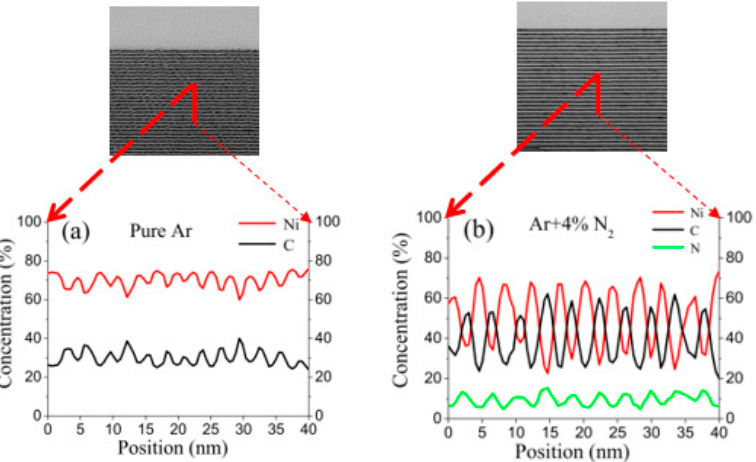
Figure 3. The atomic concentrations determined by EDS as a function of depth for Ni/C multilayers deposited with ( a ) pure Ar and ( b ) a mixture Ar + 4% N 2 as the working gas.